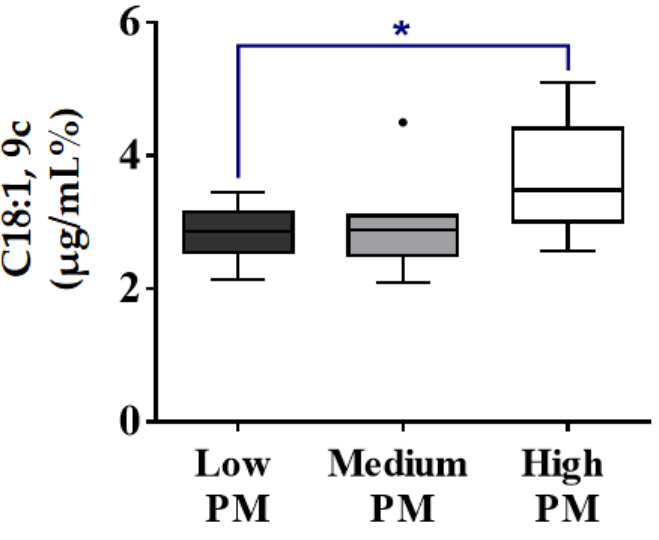
Figure 3. Relative quantitative percentage differences between healthy donkeys with spermatozoa that demonstrated low progressive motility % (Dark Gray, low PM < 35%, number = 9); medium progressive motility % (Light Gray, 35% ≤ medium PM < 45%, number = 7) and high progressive motility % (White, PM < 45%, number = 10) for oleic acid −C18:1,9c in the spermatozoa membranes. The values are given as mean ± SD. Values significantly different when compared to with each other: (*) p < 0.05. Significantly increased levels of oleic acid detected on the spermatozoa that demonstrated high PM.